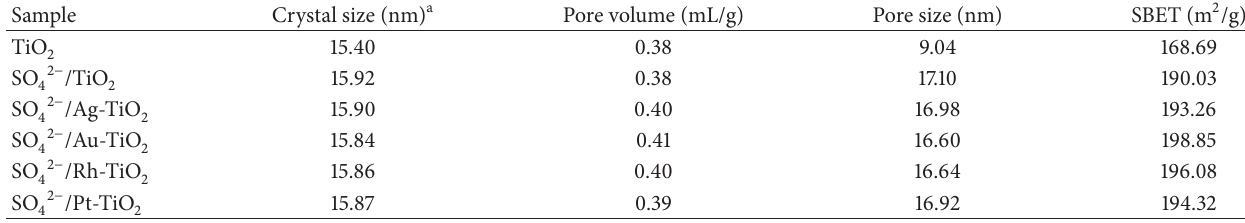
Table 1: Physicochemical characteristics of as-prepared